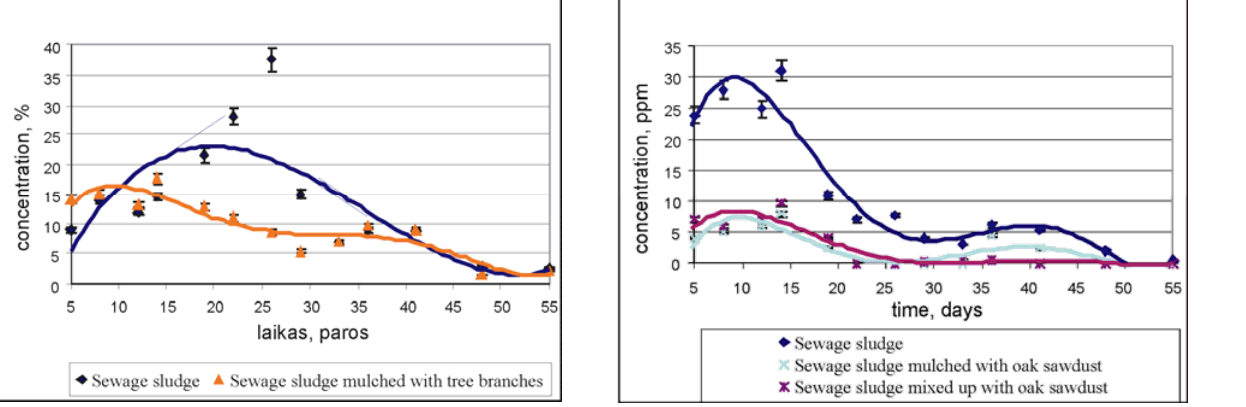
Fig. 11. Methane emissions during composting sewage sludge with minor branches